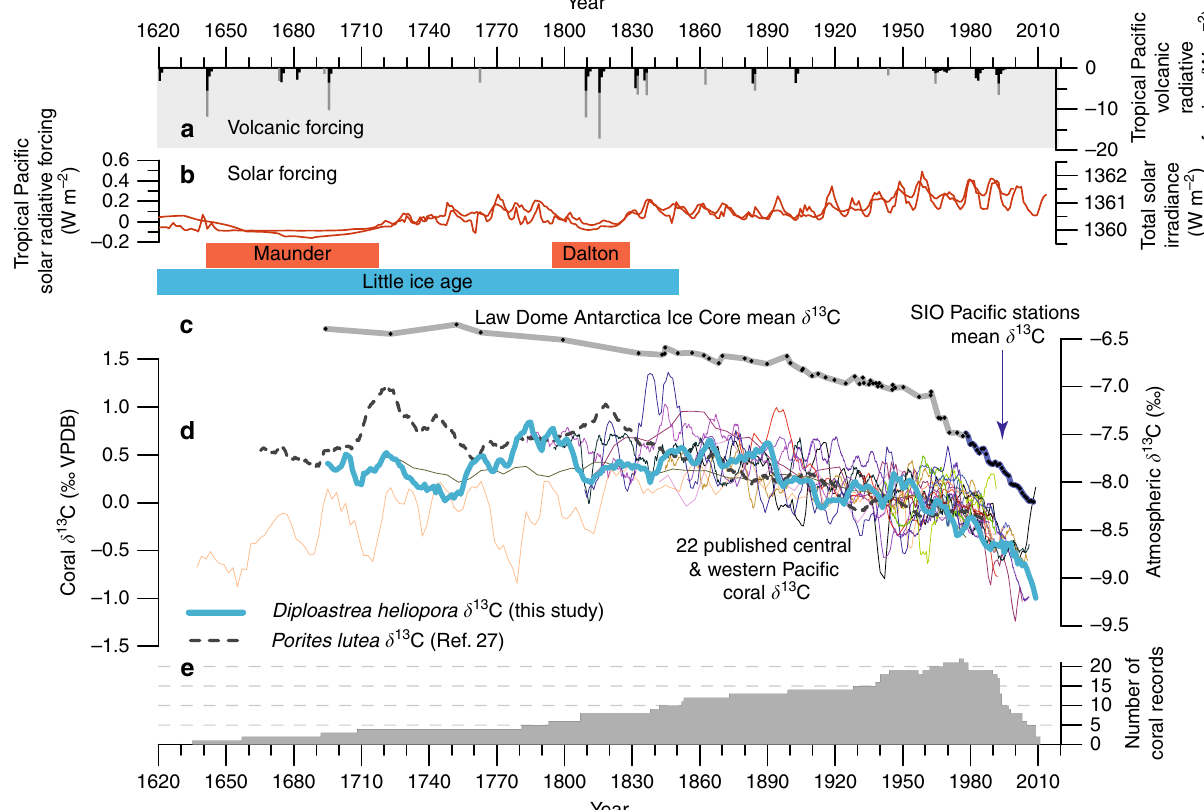
Fig. 3 Tropical Paci fi c coral δ 13 C records and external forcings. a The major tropical Paci fi c volcanic eruptions (Supplementary Table 4) and total radiative forcing from volcanic events and b solar variability 45,46 indicate a lack of direct in fl uence on the atmospheric and coral δ 13 C values. c Atmospheric δ 13 C values recorded at observation stations in the Paci fi c 42 (blue; Supplementary Table 3) and in the Law Dome Antarctica ice core (grey; mean δ 13 C record 43 ) indicate strong coherence and similar timing of signi fi cant secular depletion of δ 13 C since the industrial revolution. d Independent records of 22 published coral δ 13 C signature from the central and western Paci fi c (Supplementary Table 2) also recorded notable acceleration in long-term δ 13 C depletion due to increase in anthropogenic CO 2 output and oceanic uptake. e The individual coral time series vary in their native temporal resolution (monthly to 5-year average) and are all downscaled to 5-year moving means to facilitate comparison. Due to known inter-colony and inter-species offsets in coral δ 13